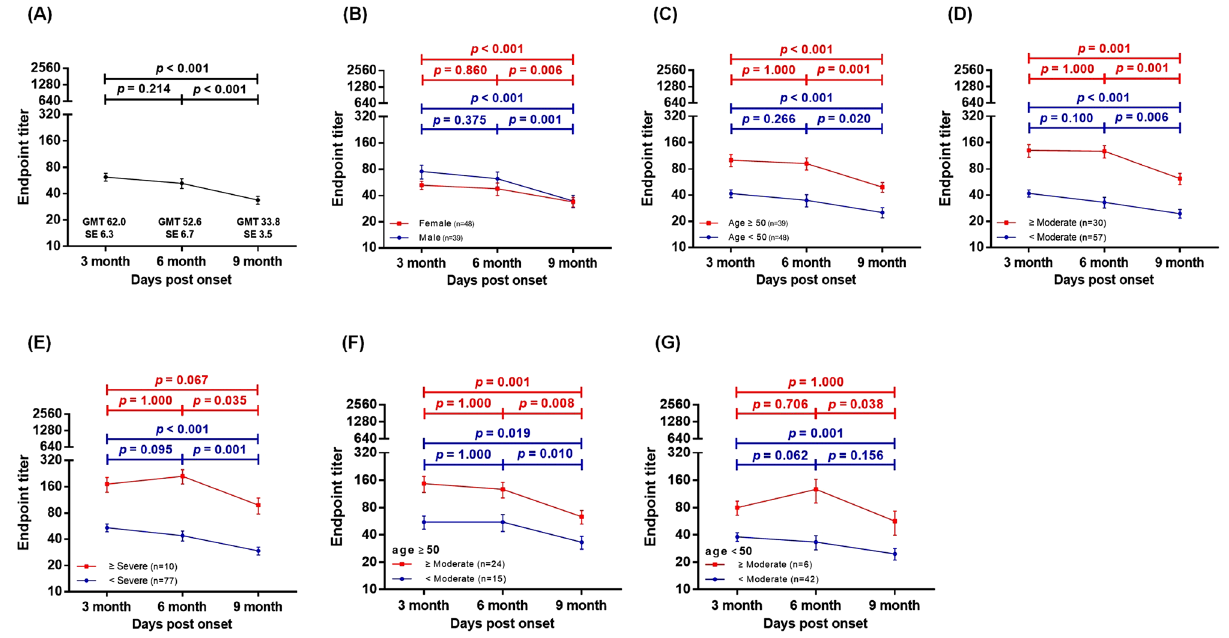
Figure 3. Variations of the neutralizing antibody (nAb) titer based on sex, age, and disease severity at intervals of 3 months. Titers are graphed as geometric mean titers (GMT) with geometric standard error. The p -values were obtained from repeated analysis of variance (ANOVA) measurements ( a ) Titers of 87 individuals who underwent blood sample collection after 3 months of COVID-19 symptom onset or diagnosis with subsequent sampling at 6 and 9 months ( b ) nAb titer variation between females and males. ( c ) nAb titer variation according to age between < 50 and ≥ 50 years. ( d ) nAb titer variation according to disease severity between < severe and ≥ severe disease severity. ( e ) nAb titer variation according to disease severity between < moderate and ≥ moderate disease severity. ( f ) nAb titers in ≥ 50 years age group according to moderate disease severity. ( g ) nAb titers in < 50 years age group according to moderate disease